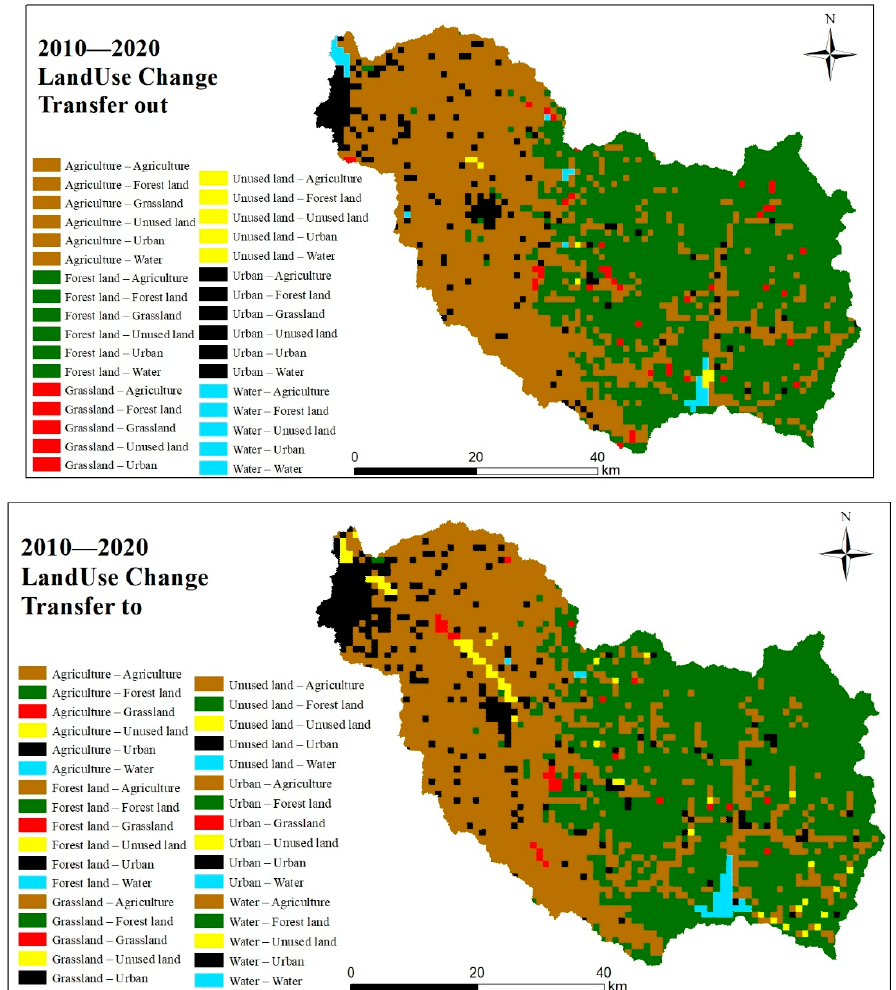
Figure 12. Land use change, 2010–2020. (Here are two different diagrams. The land use transferred from the previous image will be transferred to a different land use, which can be distinguished by color. )